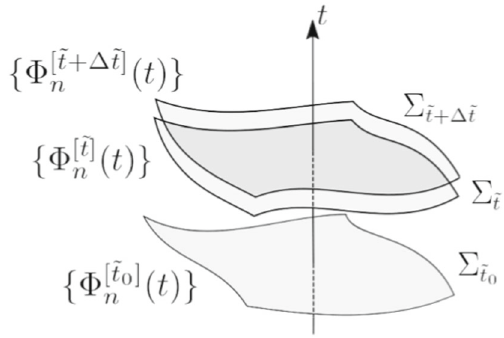
[˜ t ] ( t ) } to Cauchy hypersur- n